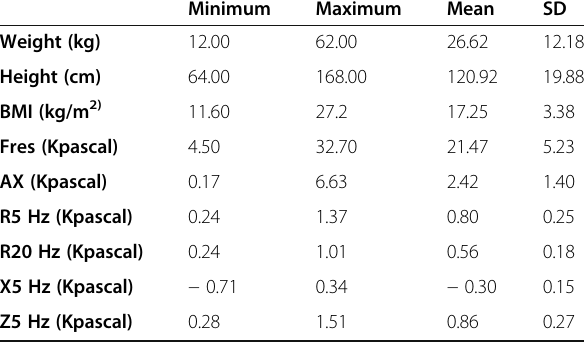
Table 1 Description of anthropometric characteristics and parameters of IOS of studied patients ( n = 113)